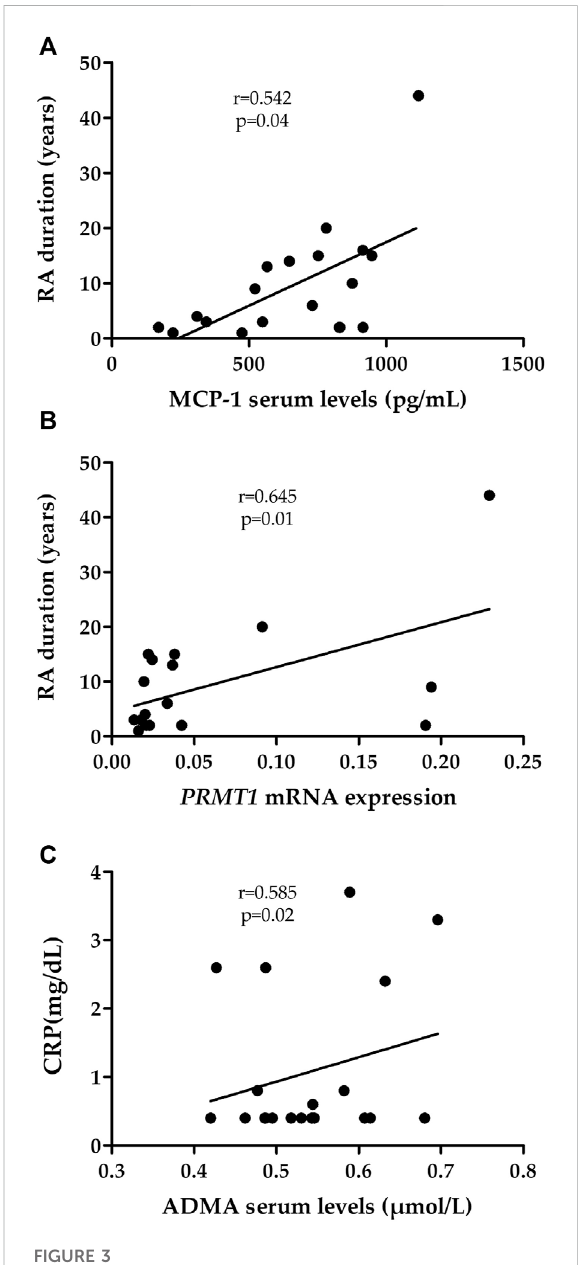
FIGURE 3 Relationship of MCP-1 (A) , PRMT1 mRNA expression (B) and ADMA (C) with clinical characteristics of RA-ILD + patients. RA, rheumatoid arthritis; MCP-1, monocyte chemoattractant protein- 1; CRP, C-reactive protein; ADMA, asymmetric